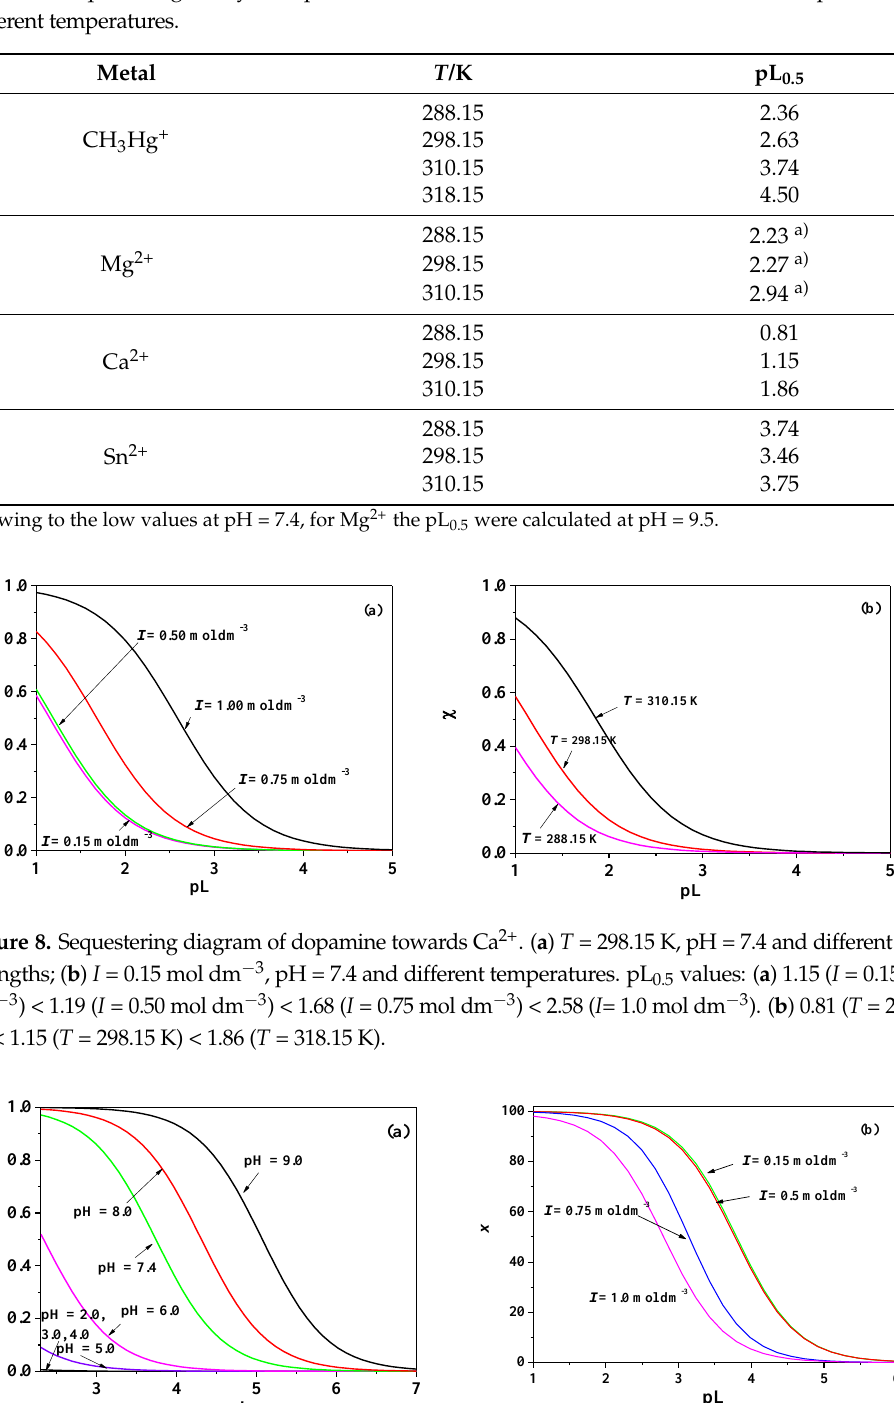
pL Figure 10. Sequestering diagram of dopamine towards the metal ions here investigated, at I = 0.15 mol L −1 , T = 298.15 K, and pH = 9.0. 0.2 (b) Figure 11. Dependence of pL 0 . 5 on: ( a ) I /mol dm −3 and ( b ) T /K. ( a ) pL 0 . 5 values calculated at T = 298.15 K, pH = 7.4 and different ionic strengths; ( b ) pL 0 . 5 values calculated at I = 0.15 mol dm −3 , pH = 7.4 and different temperatures.